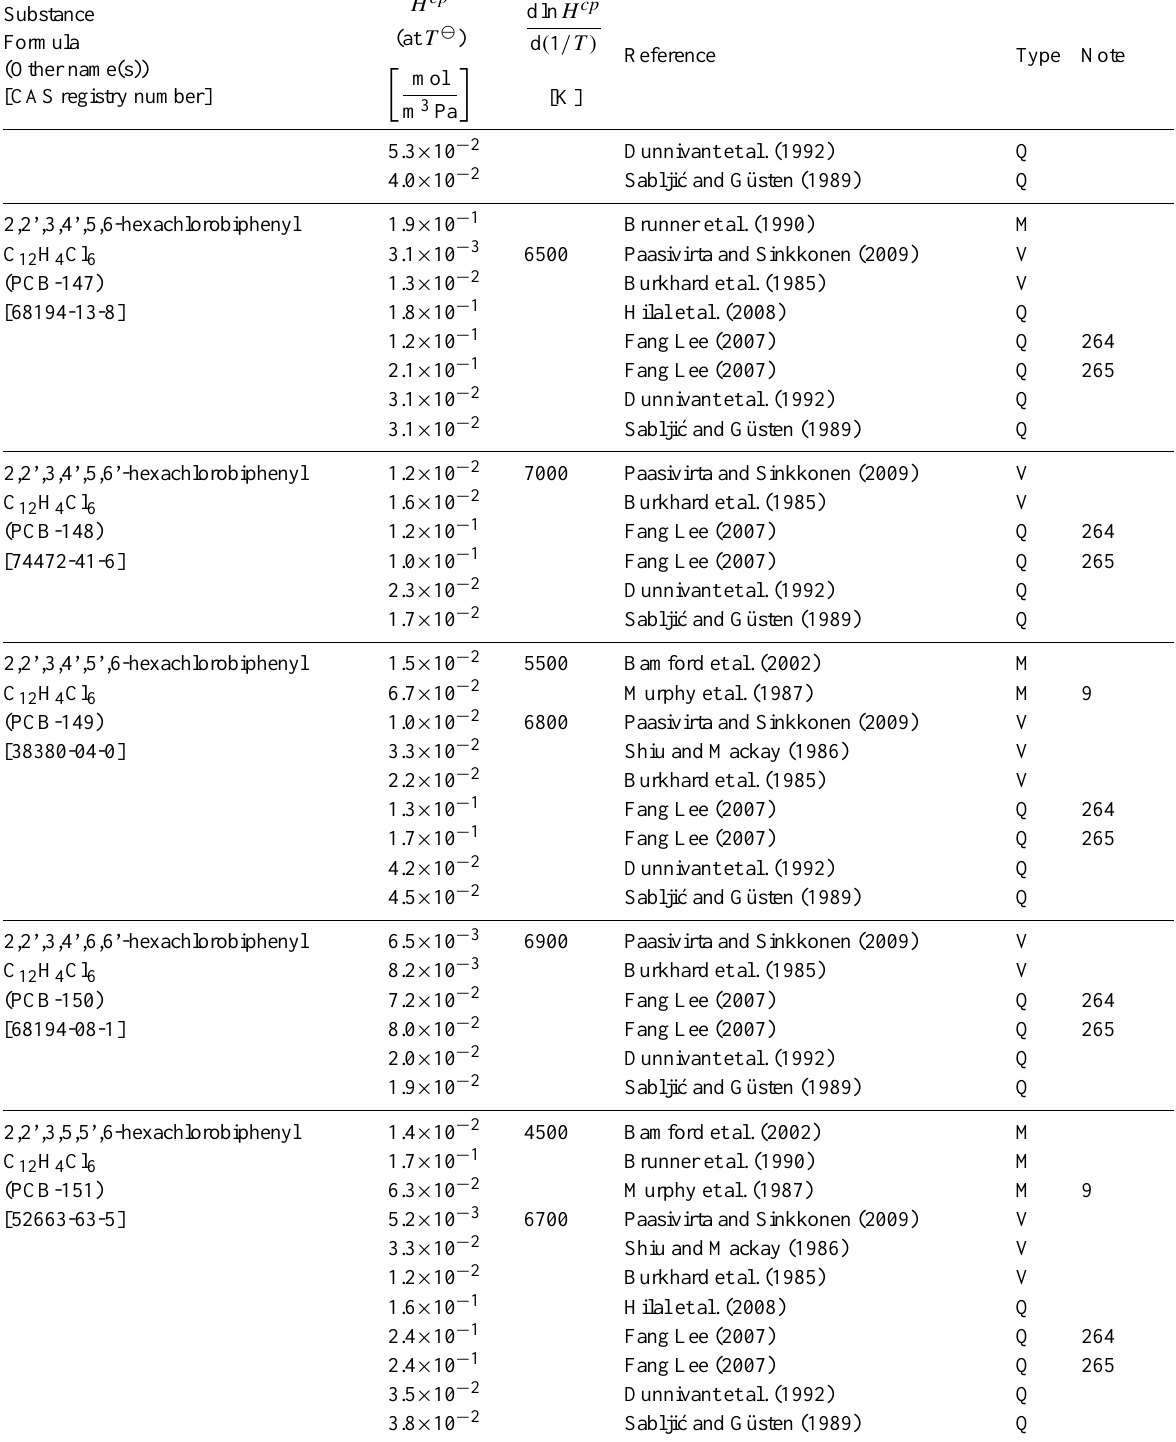
Table 6: Henry’s law constants for water as solvent